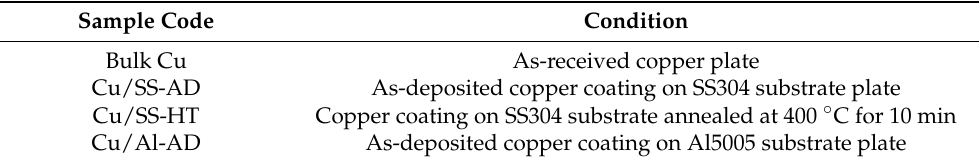
Table 3. Sample conditions